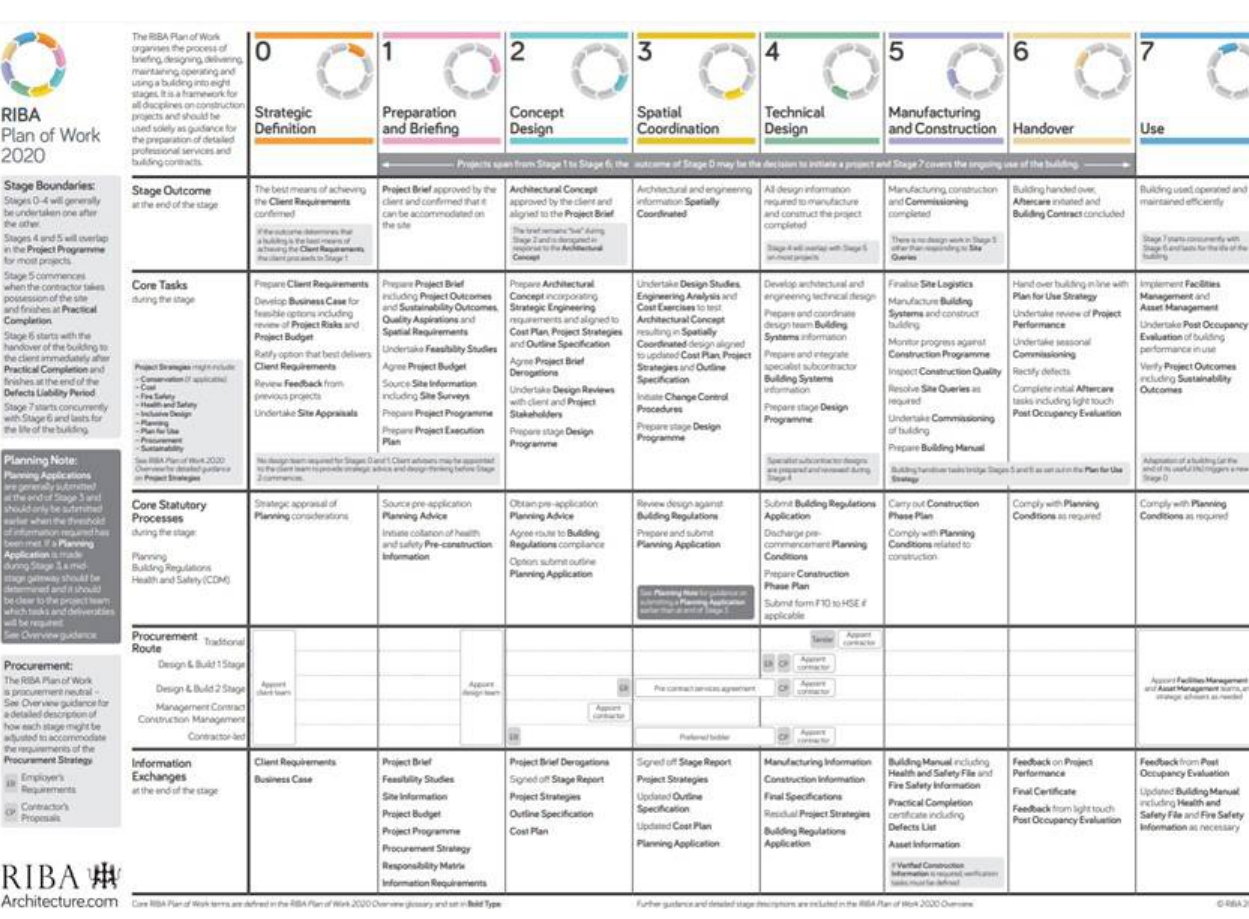
Figure 8. RIBA Plan of Work 2020.